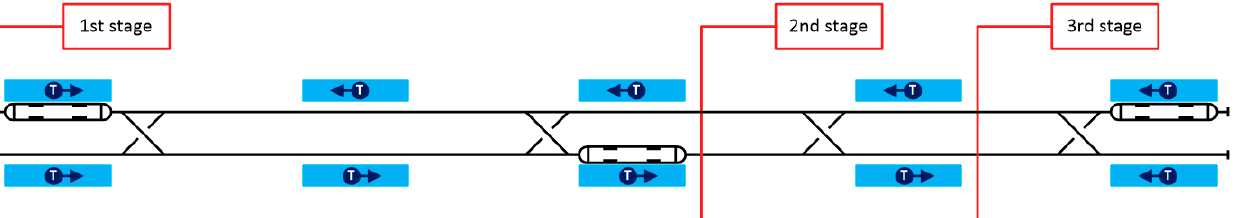
Figure 6. A bi-directional tram route commissioned in stages.